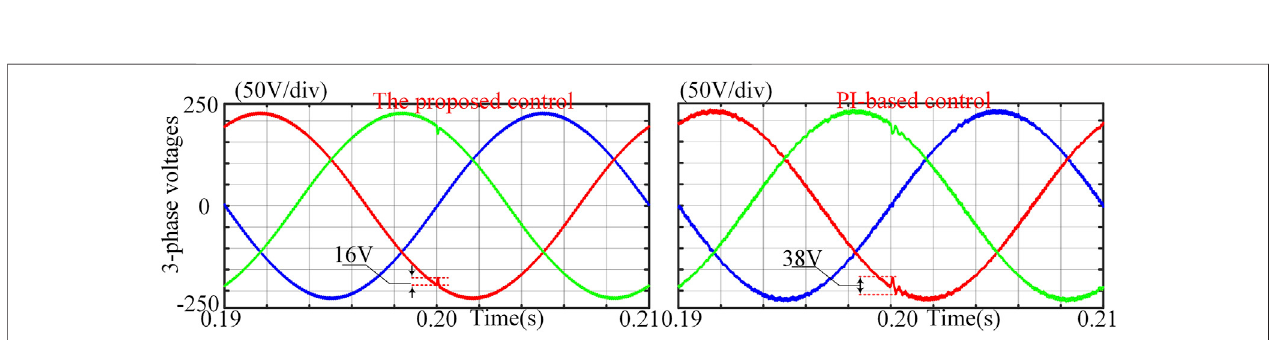
FIGURE 8 | Simulation waveforms comparison facing a step load change.